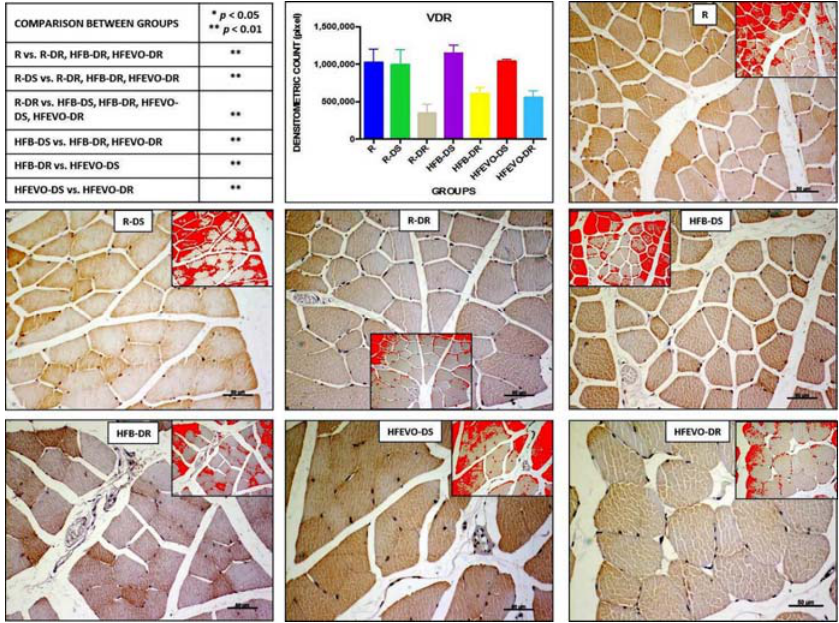
Figure 6. VDR immunostaining, image analysis by software in which the red color represents the immunolabelling (inserts), and a graph representing the intensity of immunostaining (densitometric count pixel2) with statistical analysis ( p ‐ values in the table). For details, see the text. The data are presented as mean ± SD. Scale bars: 50 μ m.